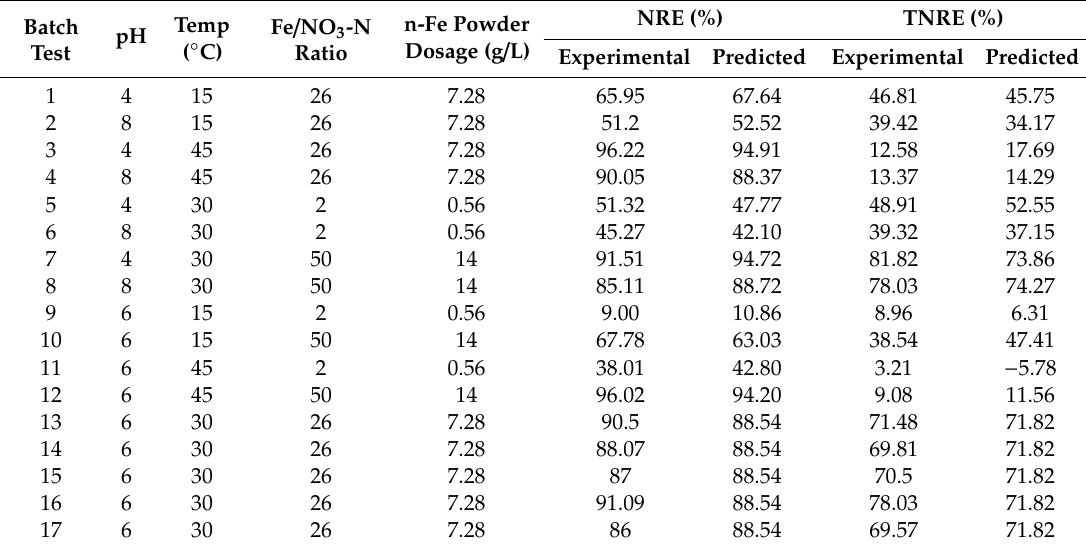
Table1. Experimentaldesignandobtainedresults. NRE / TNRE—nitrate / totalnitrogenremovalefficiency.